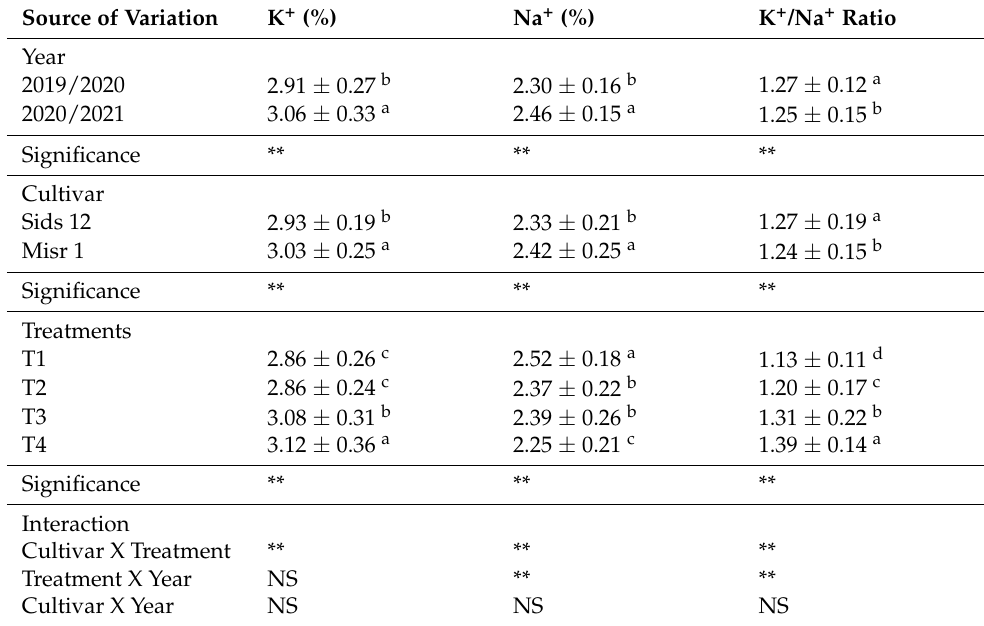
Table 4. Impact of different treatments (EM, CT, and combination) on K + , Na + , and the ratio of K + /Na + of wheat 70 days after sowing during the two growing